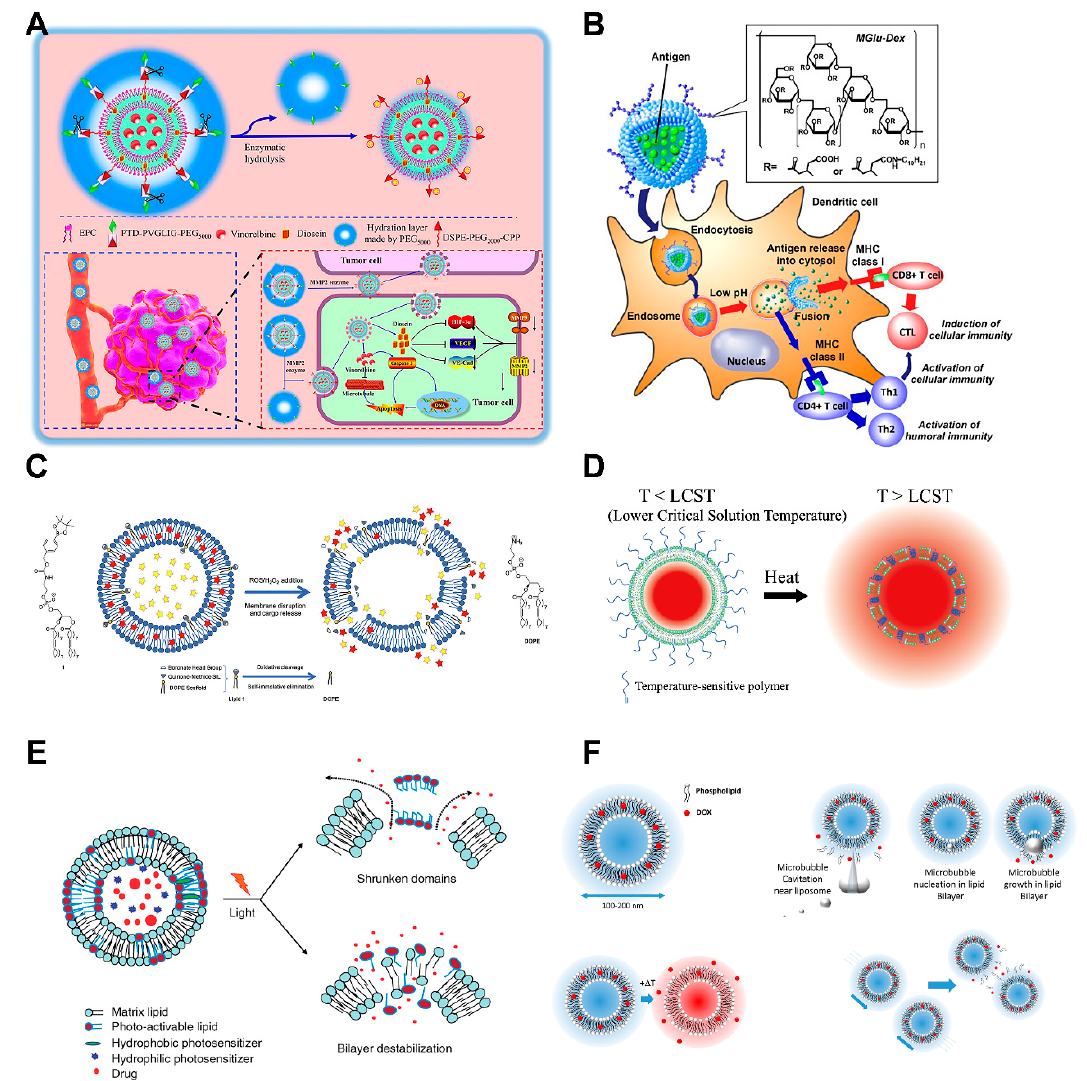
Figure 3. Demonstration diagrams of various stimulus-responsive liposomes. ( A ) Liposomes for enzyme-triggered drug delivery. Reproduced with permission from [89]. Copyright 2020, Dove Medical Press Limited. ( B ) Liposomes for PH-triggered drug delivery. Reproduced with permission from [90]. Copyright 2013, Elsevier B.V. ( C ) Reactive oxygen species (ROS)-responsive liposomes. Reproduced with permission from [91]. Copyright 2020, American Chemical Society. ( D ) Illustration of drug release from polymer-modified thermosensitive liposomes. Reproduced with permission from [92]. Copyright 2013, Elsevier B.V. ( E ) Liposomes for light-triggered drug delivery. Reproduced with permission from [93]. Copyright 2010, Taylor & Francis. ( F ) Liposomes for ultrasound-triggered drug delivery. The figure describes several ultrasound-mediated drug release mechanisms, including ultrasound-induced cavitation, focused ultrasound, and acoustic radiation force flow. Reproduced with permission from [94]. Copyright 2014, Elsevier B.V.